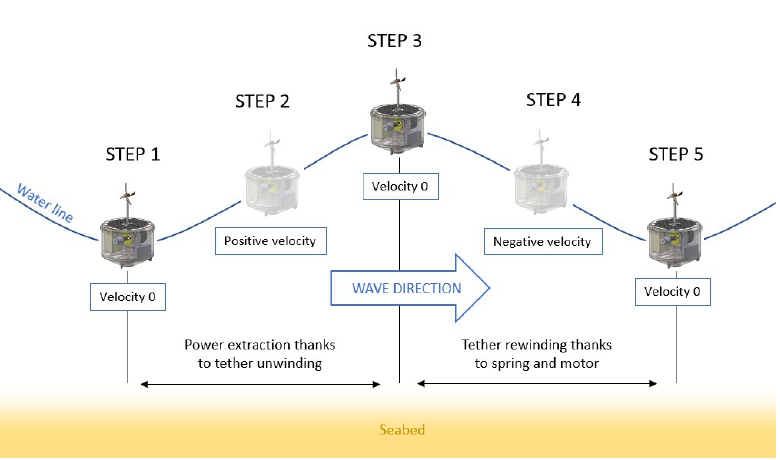
Figure 1. WEPA working